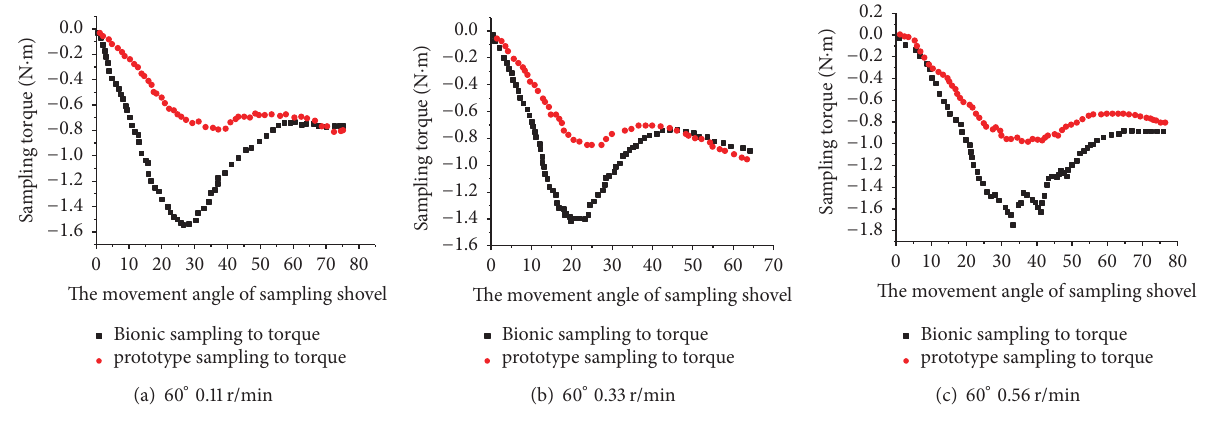
Figure 15: Torque values at different speeds when the penetration angle is 60 ∘